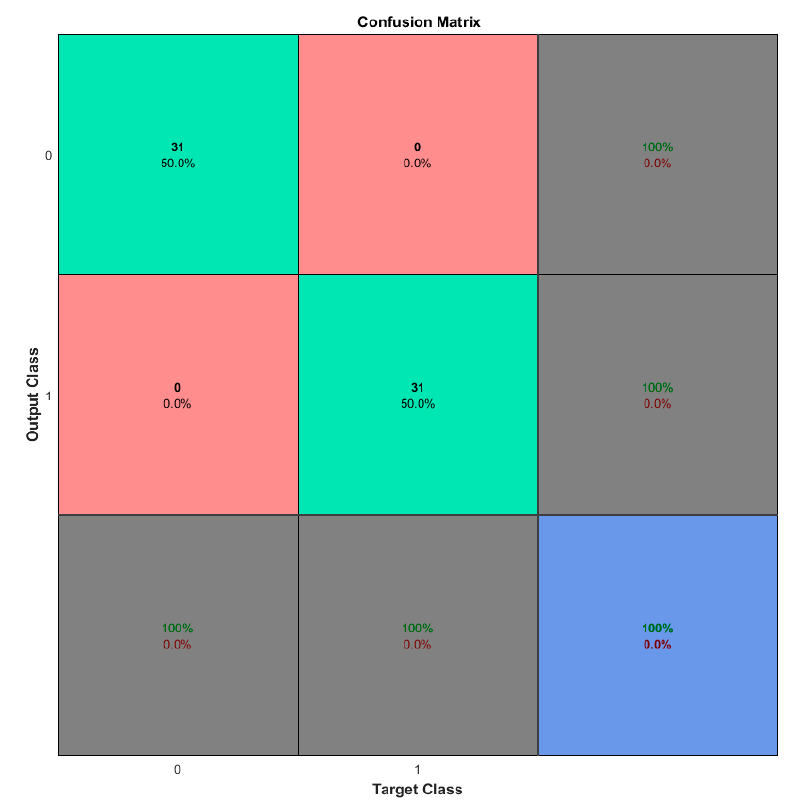
Figure 6. Confusion matrix (target/output class: “0”, Drowsy; “1”, wakeful).